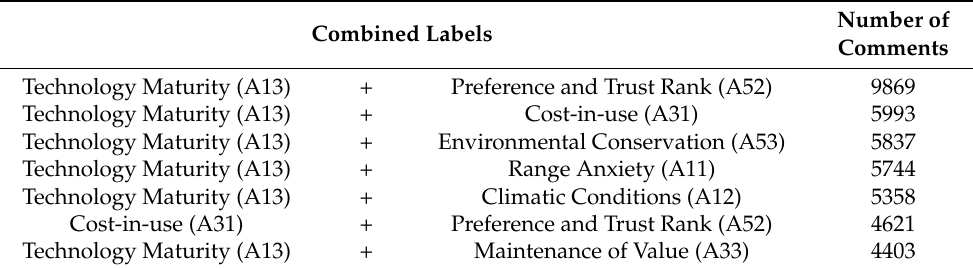
Table 5. Top 10 Combined